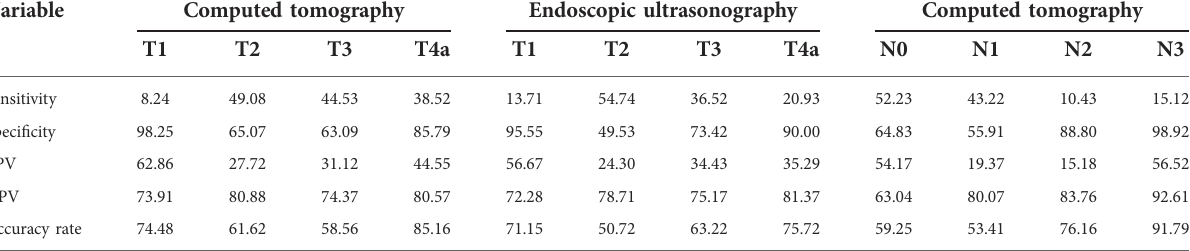
TABLE 4 Sensitivity, speci fi city, positive and negative predictive values, and accuracy rate for each T and N stage.